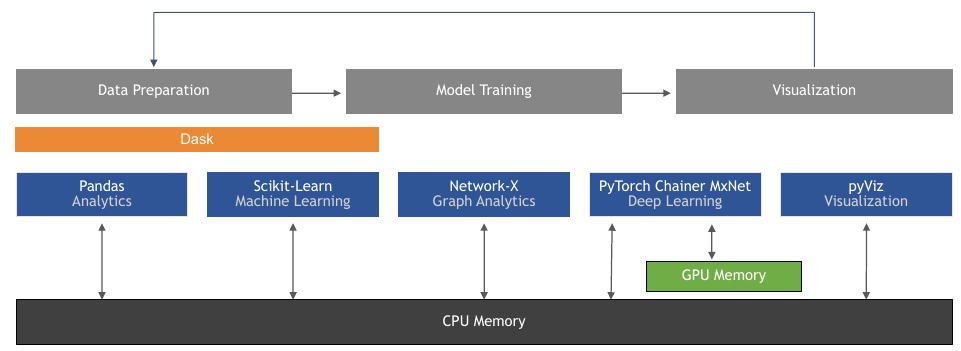
Figure 1. The standard Python ecosystem for machine learning, data science, and scientific